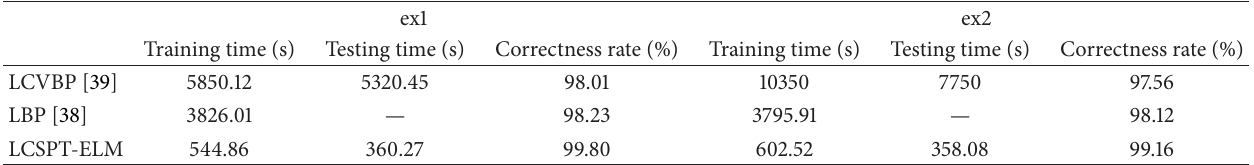
Table 3: Comparison of training time, testing time, and correctness of LCVBP, LBD, and LCSPT-ELM: the AR database. ex1 ex2 Training time (s) Testing time (s)